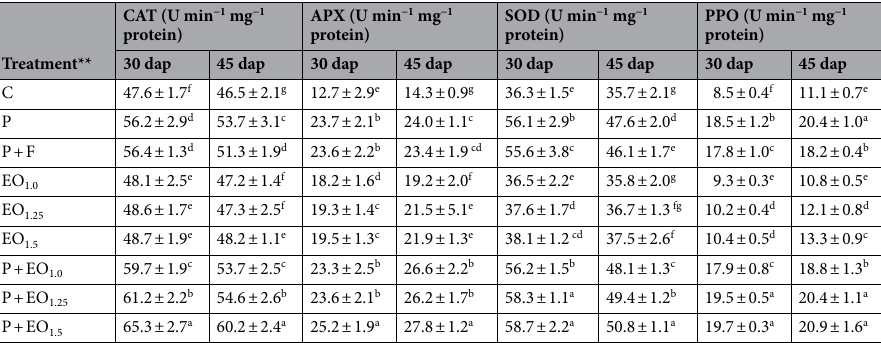
Table 5. Activities of antioxidant enzymes in sorghum plants infected with Fusarium solani in response to treatment with lavender essential oil at different concentrations. Values followed by the same letter are not significantly different according to Duncan’s multiple range test ( P ≤ 0.05), each value represents the mean of 3 replicates ± SD. **C: untreated control, P: infected with F. solani , P + F: infected with F. solani and treated with chemical fungicide (Rhizolex-T), EO 1.0 , EO 1.25 , EO 1.5 : treated with lavender EO at 1.0, 1.25, and 1.5% respectively, P + EO 1.0 , P + EO 1.25 , and P + EO 1.5 : infected with F. solani and treated with lavender EO at 1.0, 1.25, and 1.5%, respectively. CAT: catalase enzyme, APX: ascorbate peroxidase enzyme, SOD: superoxide dismutase enzyme, PPO: polyphenol oxidase enzyme, and dap: days after planting.